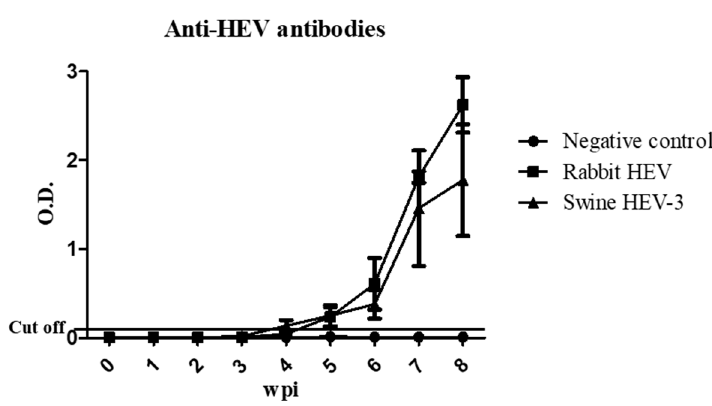
Figure 1. Determination of anti-HEV antibody titers. Anti-HEV antibody levels in serum samples were measured by ELISA at 0–8 wpi. Anti-HEV antibody levels were elevated in rabbits infected with rabbit HEV and swine HEV-3. Table 2. Detection of anti-HEV antibodies from each rabbit.